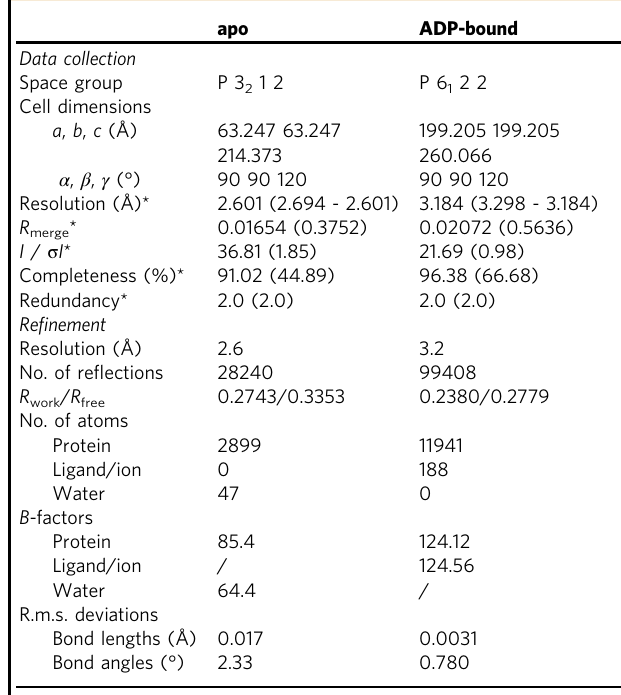
Table 1 X-ray crystallography data collection and re fi